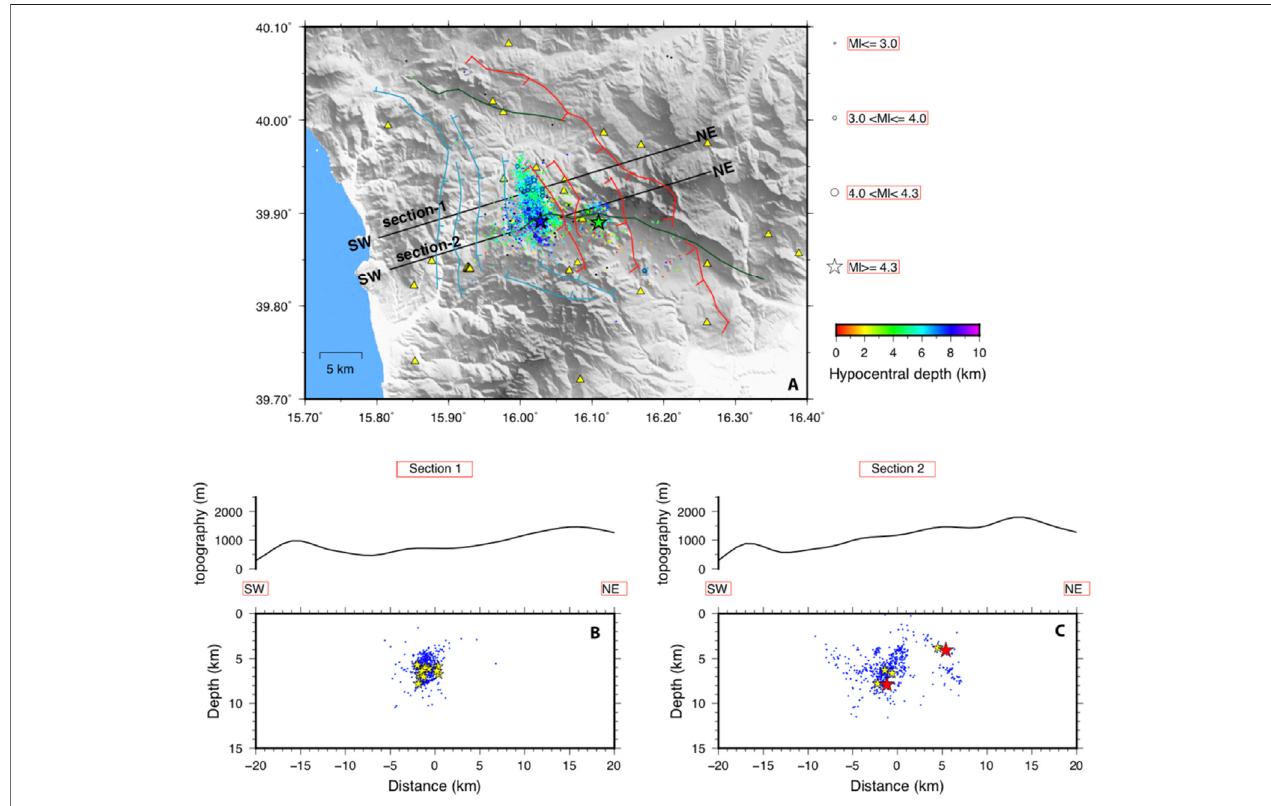
FIGURE 8 | Map and cross sections view of the earthquakes relocated using the hypoDD location. Layouts and symbols are the same as in Figure 7 .